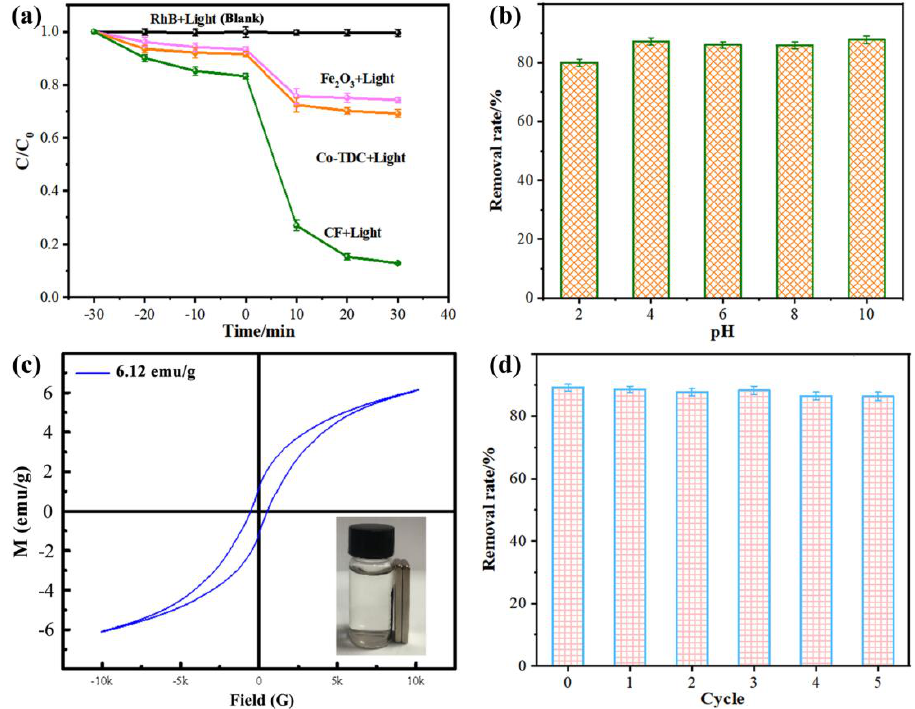
Figure 3. ( a ) RhB degradation efficiencies of different samples; ( b ) the effect of pH of reaction solution; ( c ) VSM curve of CF; ( d ) recyclability of CF photocatalyst for RhB degradation.